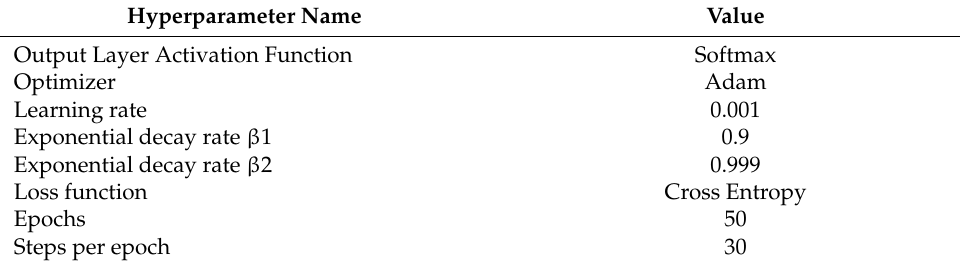
Table 3. Hyperparameters. Table 3.